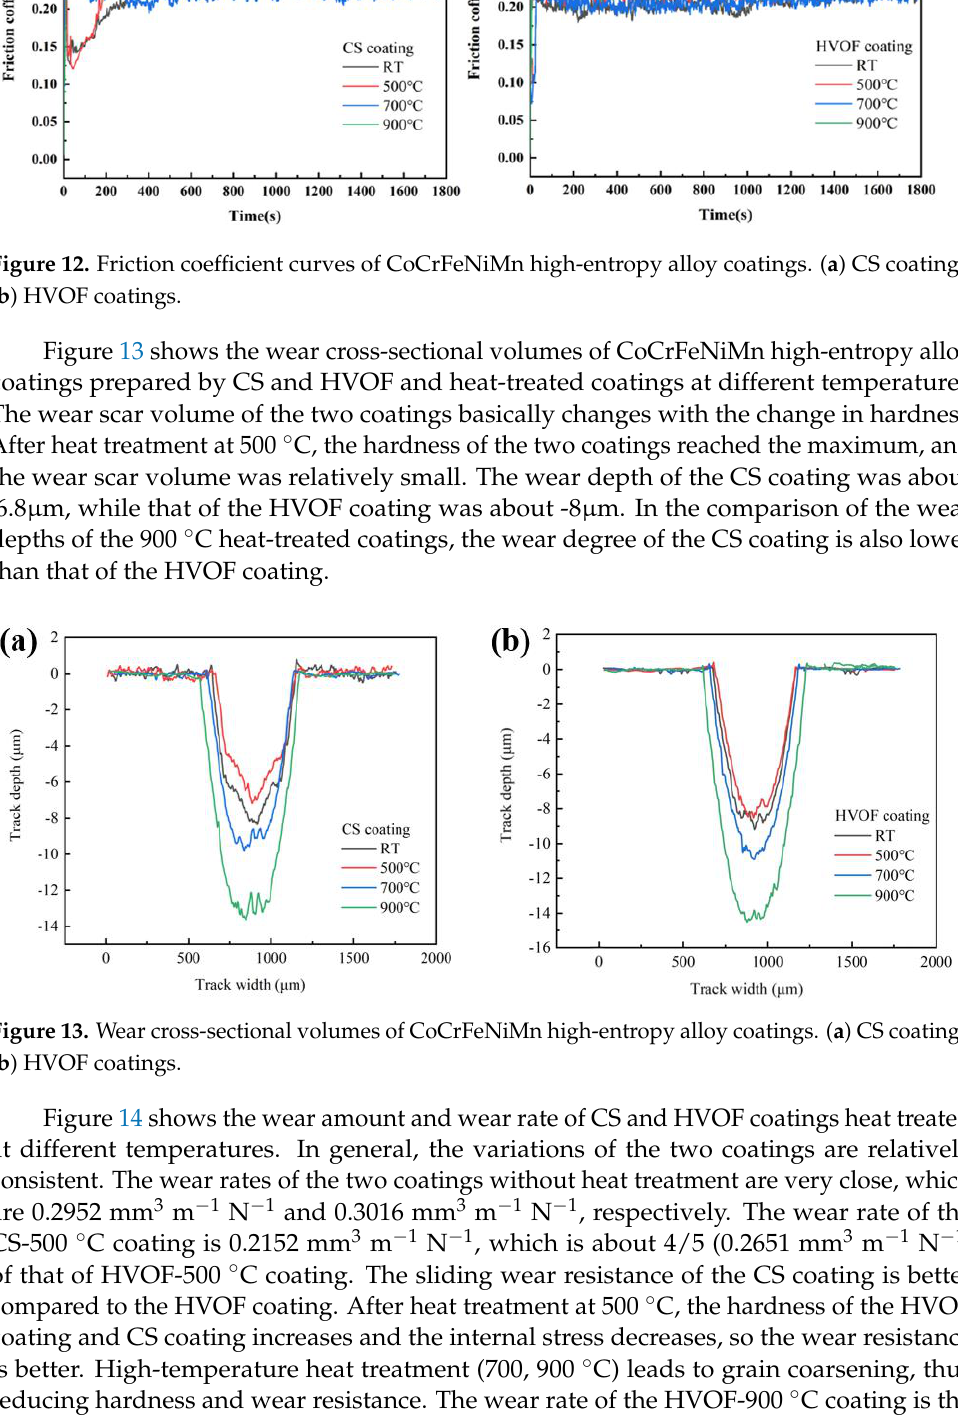
Figure 14. Wear amount and wear rate of CS and HVOF coatings heat-treated at different tempera- tures. ( a ) Wear amount; ( b ) wear rate. In order to analyze the wear mechanism of CoCrFeNiMn high-entropy alloy coatings prepared by CS and HVOF and heat-treated coatings at different temperatures, the wear morphology was characterized by SEM and EDS. Figure 15 shows the SEM wear mor- phology and EDS spectrum analysis of CS coatings under different heat-treatment condi- tions. The EDS mapping of the coatings (colored right images) is obtained based on the third image per row. The middle of two yellow dotted lines is the wear region. There are a large number of furrows on the wear surface of CS coating at room temperature, and the depth of furrows is uneven (Figure 15b,c). A small amount of enrichment of Si element can also be seen in EDS, and the enrichment area is consistent with the position of deep